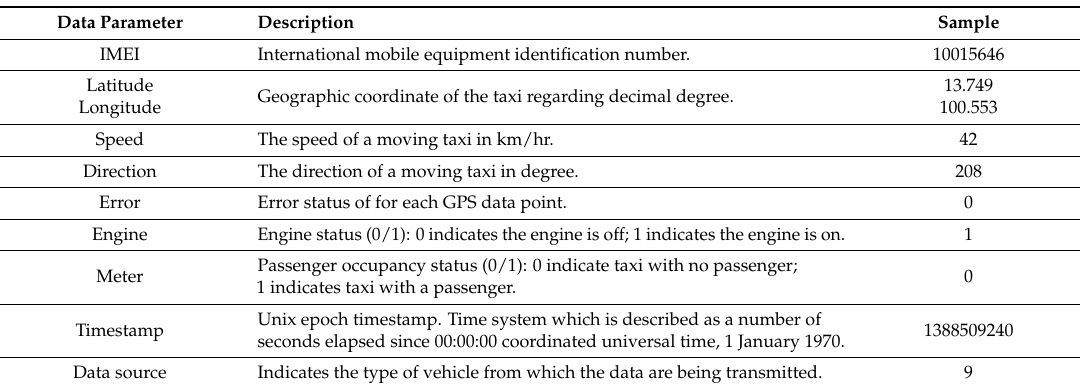
Table 1. Probe data